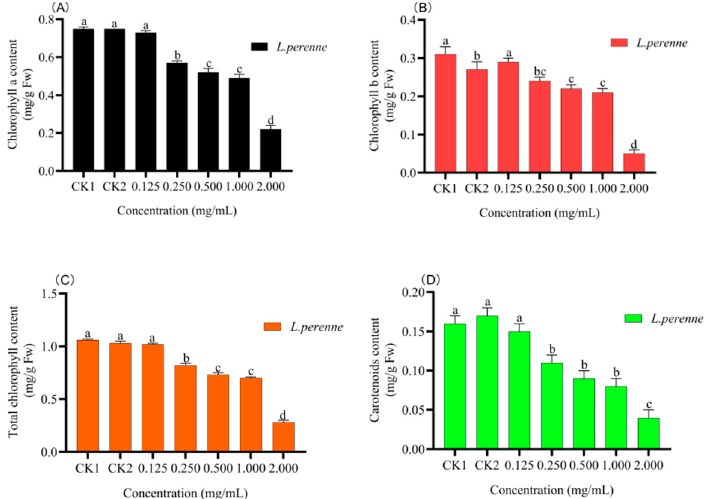
Figure 5. Effect of different concentration of L. pungens essential oil on photosynthetic pigments content (CK1, blank control; CK2, negative control; ( A ), Chlorophyll a content; ( B ), Chlorophyll b content; ( C ), Total chlorophyll content; ( D ), Carotenoids content). Note: different lowercase letters (a–d) represent statistical differences (Tukey’s test p < 0.05).